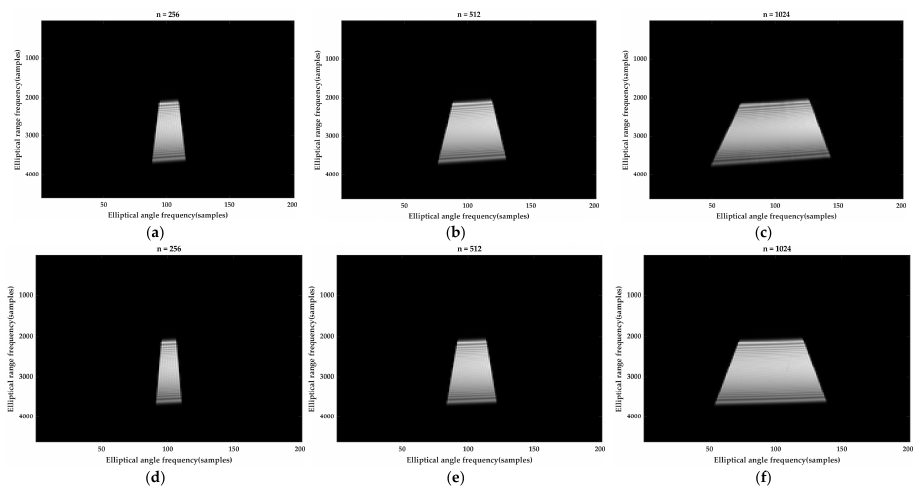
Figure 6. Two-dimensional (2D) spectrum comparison of the imaging result of the single ideal point target with the di ff erent subaperture lengths 𝑛 . ( a ) Two-dimensional (2D) spectrum for 𝑛 = 256 in the EP system; ( b ) Two-dimensional (2D) spectrum for 𝑛 = 512 in the EP system; ( c ) Two-dimensional (2D) spectrum for 𝑛 = 1024 in the EP system; ( d ) Two-dimensional (2D) spectrum for 𝑛 = 256 in the OEP system; ( e ) Two-dimensional (2D) spectrum for 𝑛 = 512 in the OEP system; ( f ) Two-dimensional (2D) spectrum for 𝑛 = 1024 in the OEP system. Table 1. Two-dimensional (2D) spectrum angular width of the single ideal point target with the di ff erent subaperture lengths 𝑛 . Bistatic EP FFBP Proposed Bistatic FFBP Subaperture Length Upgrade Factor ( Sampling Point ) ( Sampling Point ) 256 25